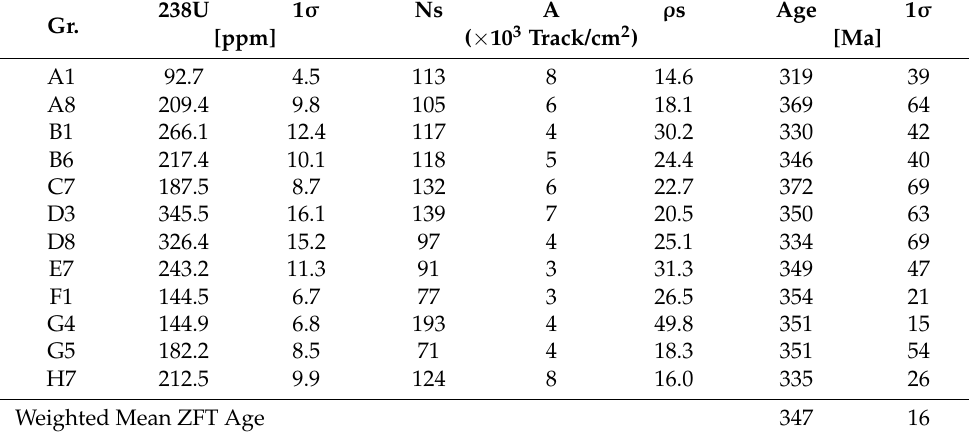
Gr = Grains, A1 grain symbol, U; Uranium concentration in ppm, 1 σ = uncertainty of 1-sigma, Ns; number of spontaneous tracks, A; Area in square microns, ρ s; density of spontaneous tracks (10 3 tr/cm 2 ), W.M. age; weighted mean age in million years calculated using IsoplotR